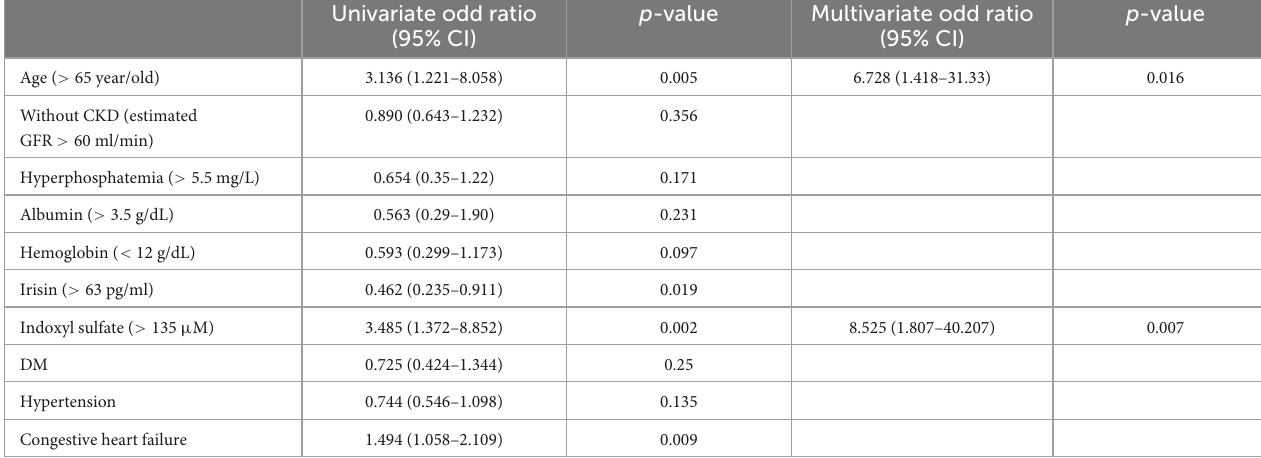
TABLE 5 Univariate and Multivariate logistic regression analyses for the factors associated with low handgrip